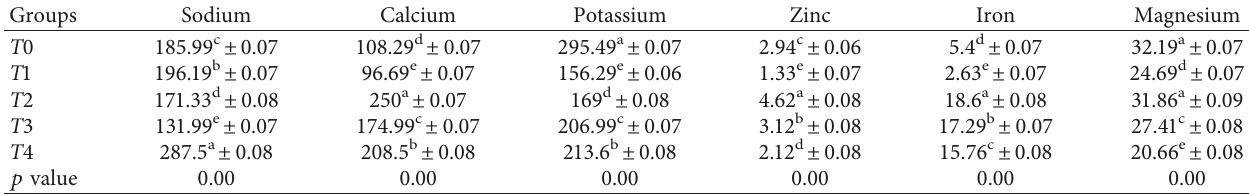
Table 5: Mineral analysis of various gluten-free cupcakes and control (mg/100 grams).